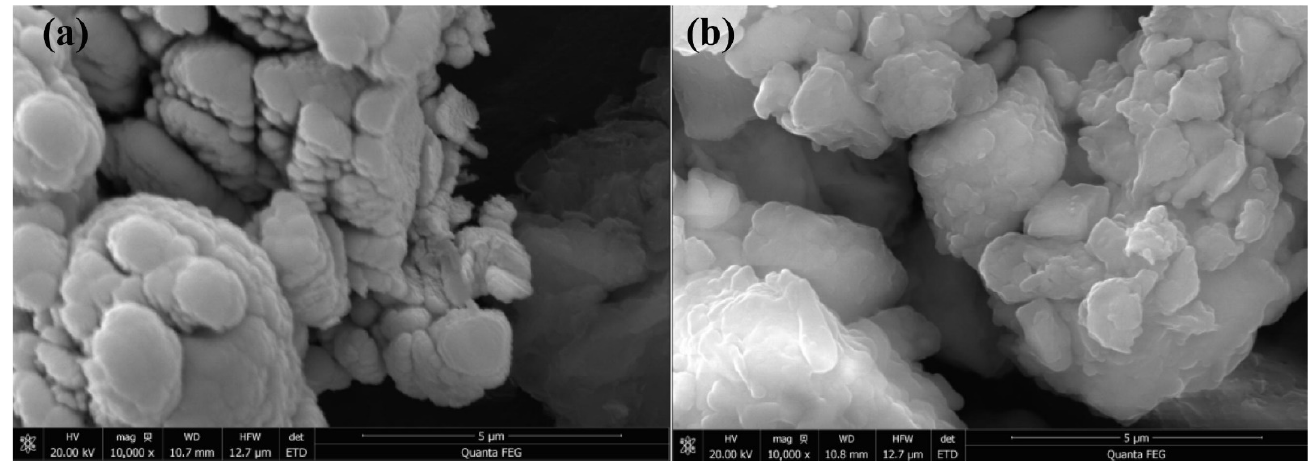
Figure 1. The SEM images of ( a ) BT and ( b ) OBT.